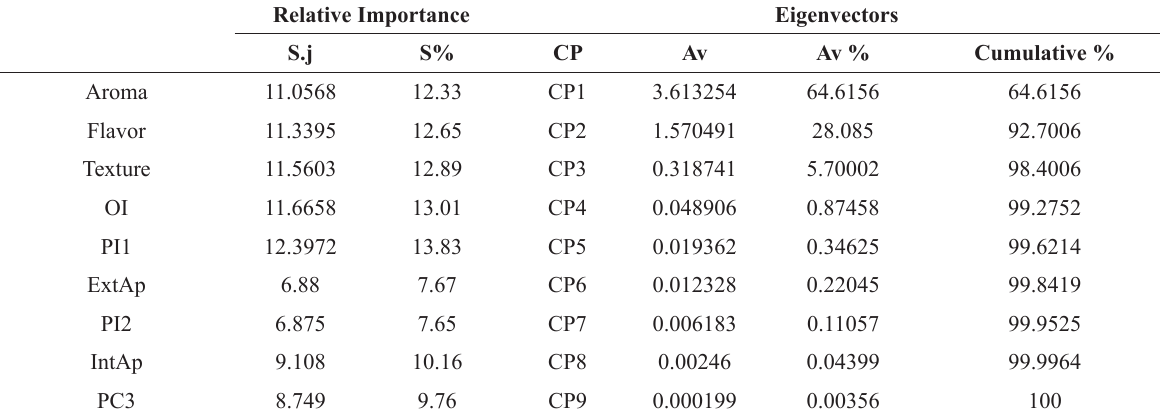
The relative importance of the traits (Sing method) and estimate of eigenvectors associated to the principal components. Relative